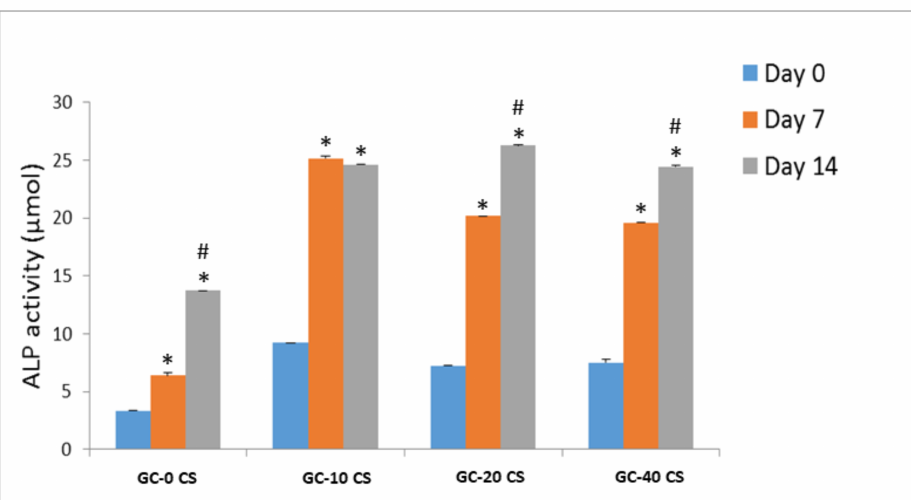
Figure 6. Alkaline phosphatase release of hBMSCs seeded in GC-0 CS, GC-10 CS, GC-20 CS, and GC-40 CS scaffolds at days 0, 7, and 14. Statistical analyses: One-way ANOVA followed by Post-Hoc LSD test; * p < 0.05 indicates the level of statistical significance between days 7, and 14 against day 0; # p < 0.05 indicates comparison between days 7 and 14.